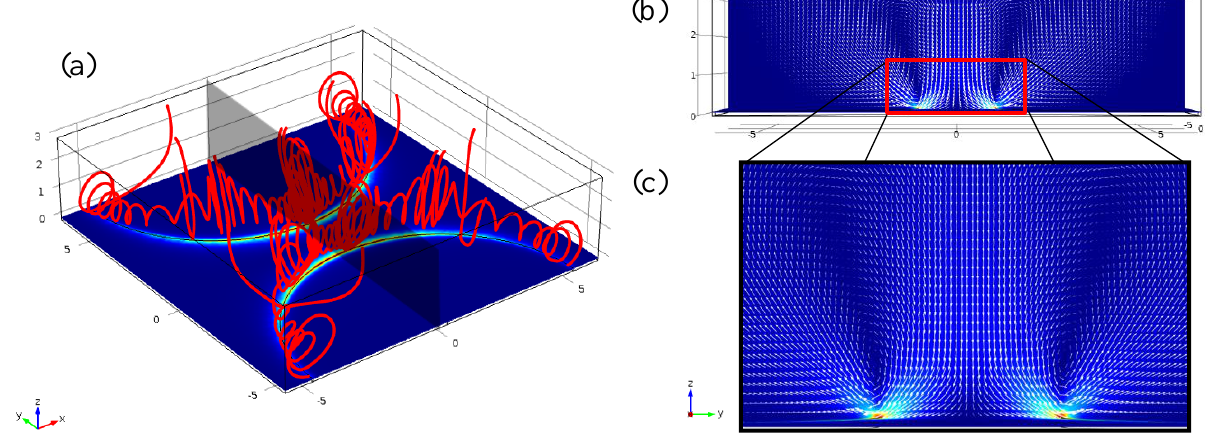
Figure 5. Simulation results of flow generated by the electroosmosis above the planar electrodes ( a) Streamlines near the electrode edges; ( b ) Velocity vectors in the plane that indicated by the gray color in (a); ( c ) Magnified image of velocity vectors in vicinity of the